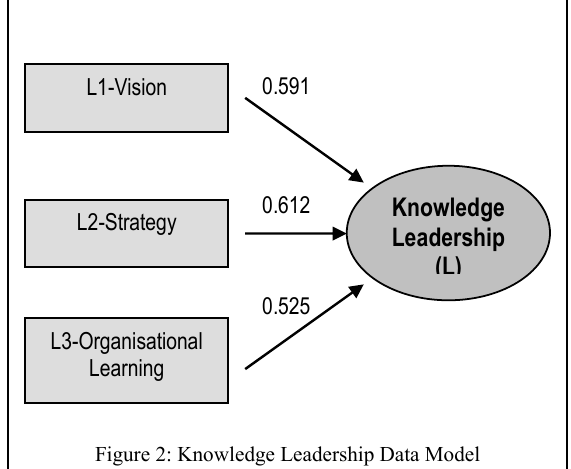
Figure 2: Knowledge Leadership Data